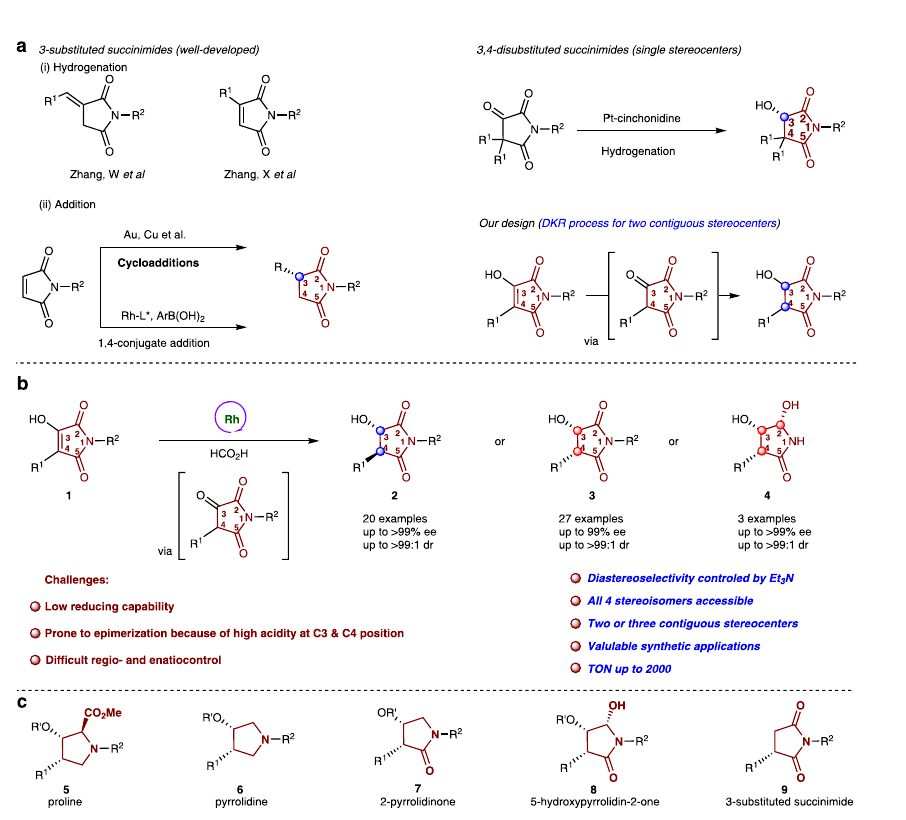
Fig. 2 | Synthetic methods for the construction of chiral succinimide derivatives. a Catalytic asymmetric synthesis of chiral succinimides (previous work) . b Stereodivergent synthesis of chiral succinimide derivatives via ATH (this work). c Obtained building